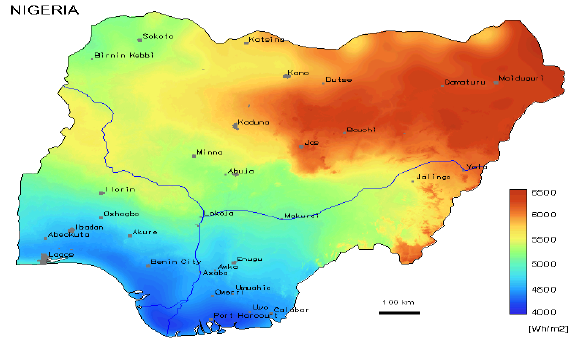
Figure 1: Solar Radiation Map of Nigeria